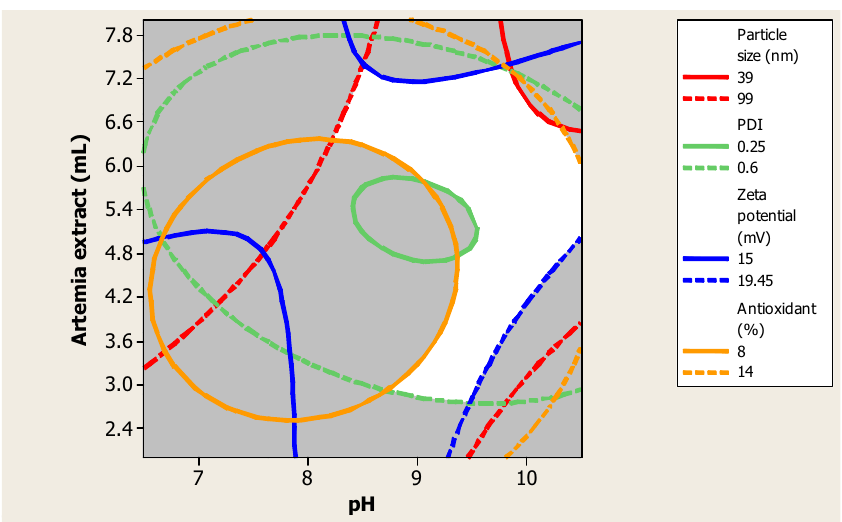
Figure 6: Overlaid contour plot of Au NPs particle size, PDI, zeta potential and antioxidant activity as a function of amount and pH of the prepared A. urumiana extract.